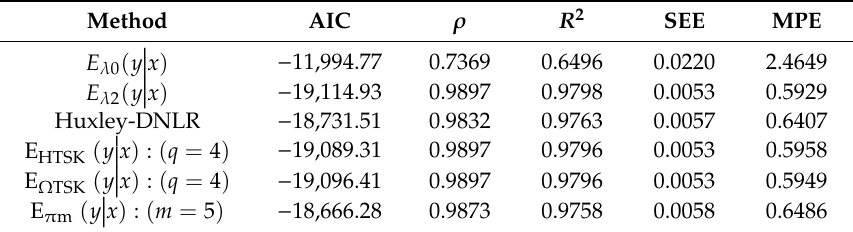
Figure 4. Comparison of λ 2 ( u ) and Ω TSK ( u ) MCA fits the simulated non-lognormally distributed data. Figure 4 . Comparison of 𝜆 (cid:2870) (𝑢) and Ω (cid:3021)(cid:3020)(cid:3012) (𝑢) MCA fits the simulated non-lognormally distributed (cid:12) (cid:12) Panel ( a ) comparison of mean response functions E λ 2 ( u (cid:12) v ) and E Ω TSK ( u | v ) . Panel ( b ) compares related data. Panel ( a ) comparison of mean response functions 𝐸 (cid:3090)(cid:2870) (𝑢|𝑣) and 𝐸 (cid:2960)(cid:3021)(cid:3020)(cid:3012) (𝑢|𝑣) . Panel ( b ) compares (cid:12) (cid:12) (cid:12) (cid:12) (cid:12) (cid:12) (cid:12) (cid:12) retransformed forms E λ 2 ( y (cid:12) x ) and E Ω TSK ( y (cid:12) x ) . Panel ( c ) compares E λ 2 ( y (cid:12) x ) to E HTSK ( y (cid:12) x ) acquired related retransformed forms 𝐸 (cid:3090)(cid:2870) (𝑦|𝑥) and 𝐸 (cid:2960)(cid:3021)(cid:3020)(cid:3012) (𝑦|𝑥). Panel ( c ) compares 𝐸 (cid:3090)(cid:2870) (𝑦|𝑥) to 𝐸 (cid:2943)(cid:2904)(cid:2903)(cid:2895) (𝑦|𝑥) from regression model of Equation (34) fitted in direct arithmetical scales. Panel ( d ) is a comparison of acquired from regression model of Equation (33) fitted in direct arithmetical scales. Panel ( d ) is a (cid:12) (cid:12) (cid:12) (cid:12) E Ω TSK ( y comparison of 𝐸 (cid:2960)(cid:3021)(cid:3020)(cid:3012) (𝑦|𝑥) to 𝐸 (cid:3017)(cid:3018)(cid:2870) (𝑦|𝑥) , the directly acquired projection function. This is obtained (cid:12) x ) to E PQ 2 ( y (cid:12) x ) , the directly acquired projection function. This is obtained by replacing fitted parameter vector PQ into addressed MCA form in arithmetical space. We can be aware of dependable projections even without a correction factor (CF). Table 2. Performance statistics for addressed proxies fitted on data simulated by the procedure of Equation (44) (non–normal errors). AIC stands for Akaike’s information criterion, ρ symbolizes Lin’s concordance correlation coe ffi cient, R 2 denotes determination coe ffi cient, SEE standard error of estimation and MPE mean prediction